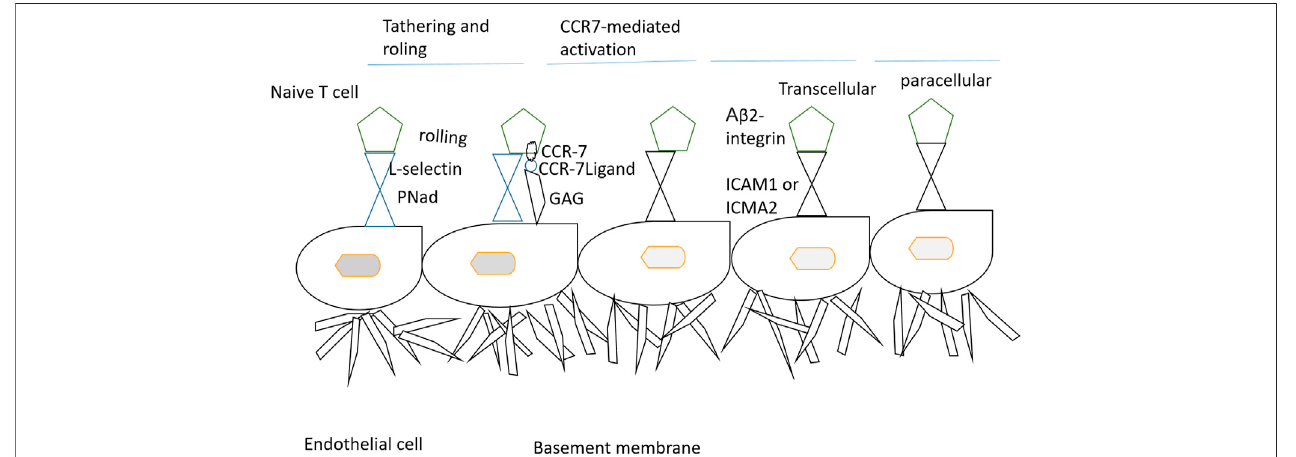
FIGURE1| Stepwise mechanism oflymphocyte homing tothelymphnodes. The T-cellswhen emergingfrom theblood enter theperipheral lymphnodes through the tethering and rolling mechanism, activation of CCR7, fi rm arrest, and transendothelial migration. At fi rst, L-selection of lymphocyte binds with peripheral node addressins(PNAd)andsialomucinsonhighendothelialvenules(HEVs).TheinteractionresultsinT-cellattachmenttoHEVsandresultsincellrolling.Therollingcellsthen interactwithCCL21/CCL19andthusareimmobilizedbyglycosaminoglycans(GAGs).ThesignalsfromCCR7andblood fl owforceinduceconformationalchanges in α L β 2- integrins,thus allowing fi rm bindingtointracellularaddressincelladhesionmolecular 1(ICAM1) andICAM2.CCR7alsoactivates α L β 2- integrinmucosaladdressin cell-adhesion molecule 1 (MAdCAM) (Förster et al.,